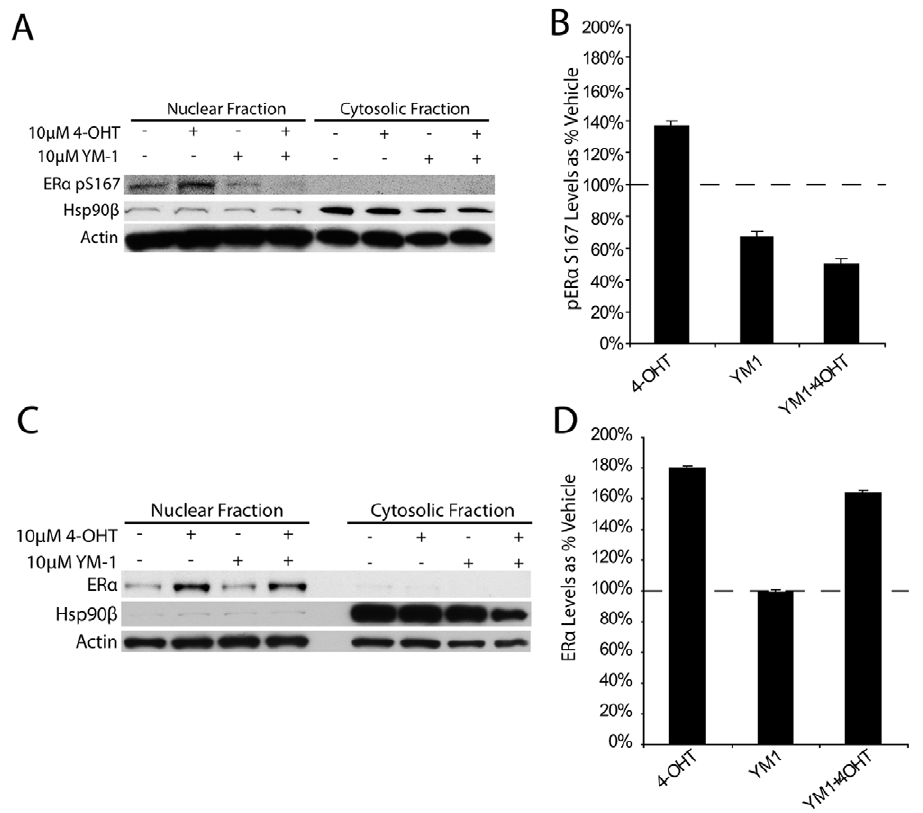
Figure 5. Phosphorylation but not localization of Estrogen Receptor a altered by YM-1. TR-MCF7 cells were treated with indicated conditions for 4 hours. Nuclear isolates and cytosolic fractions were compared by Western blot, representative blots shown (A & C). Densitometry analysis of pER a and ER a levels displayed as % of vehicle treatment 6 SD (B & D).